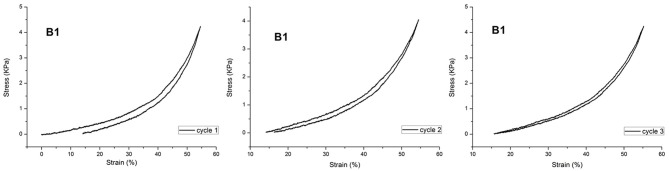
Cyclic compression curves for B1.